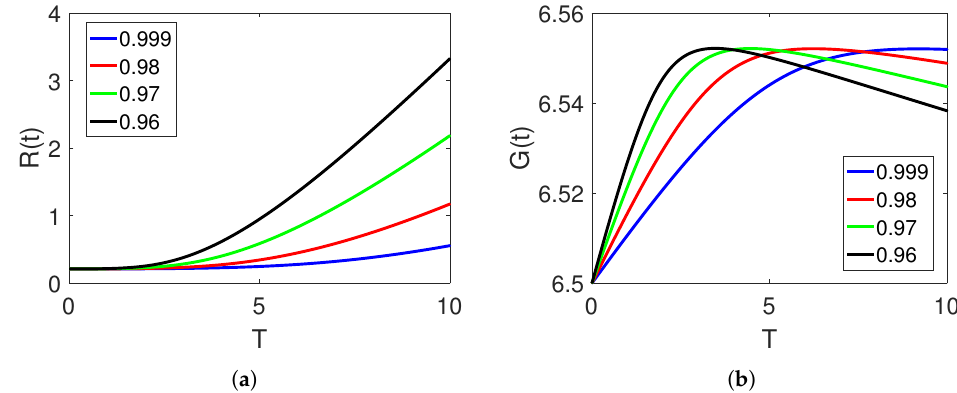
Figure 9. Dynamical of the recovered class ( a ) and isolated class ( b ) on different arbitrary fractional order ς on sub interval [ 0, t 1 ] and [ t 1 , T ] of [ 0, T ] for different time